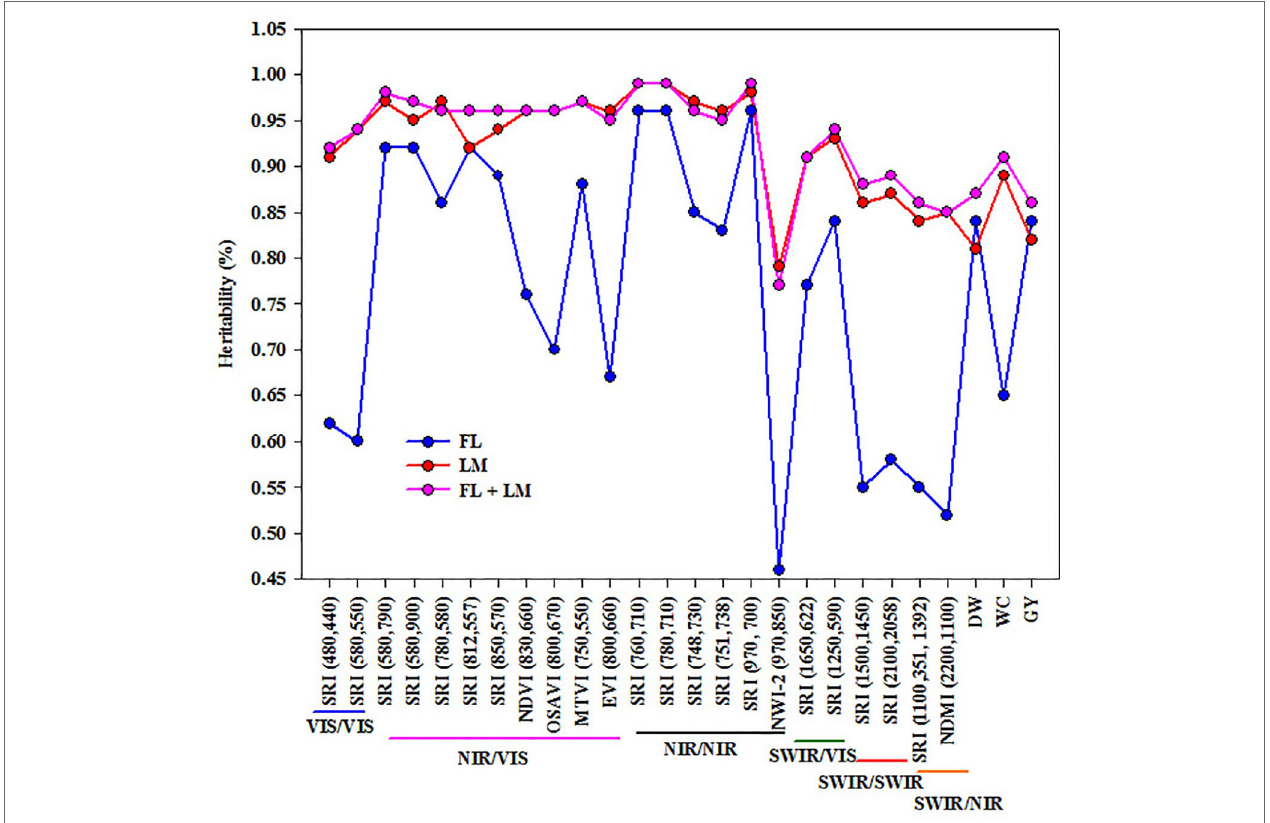
FIgURe 4 | Broad-sense heritability (%) for different spectral reflectance indices and three measured parameters (shoot dry weight per square meter (DW), water content of aboveground biomass (WC), and grain yield per hectare (GY)) under full irrigation (FL), limited irrigation (LM), and the combined two treatments (FL+LM).